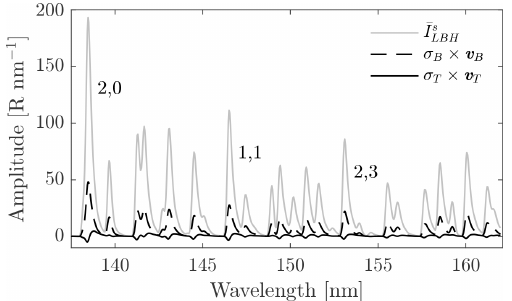
Figure 2. The second principal component (black line), v T , over the LBH (2,0) band and the normalized amplitude of the LBH (2,0) band at five N 2 rotational temperatures, T r . Emissions at 138.56nm, where v T changes the sign, are independent of temperature and pro- vide a boundary to split the (2,0) band into channels A and B